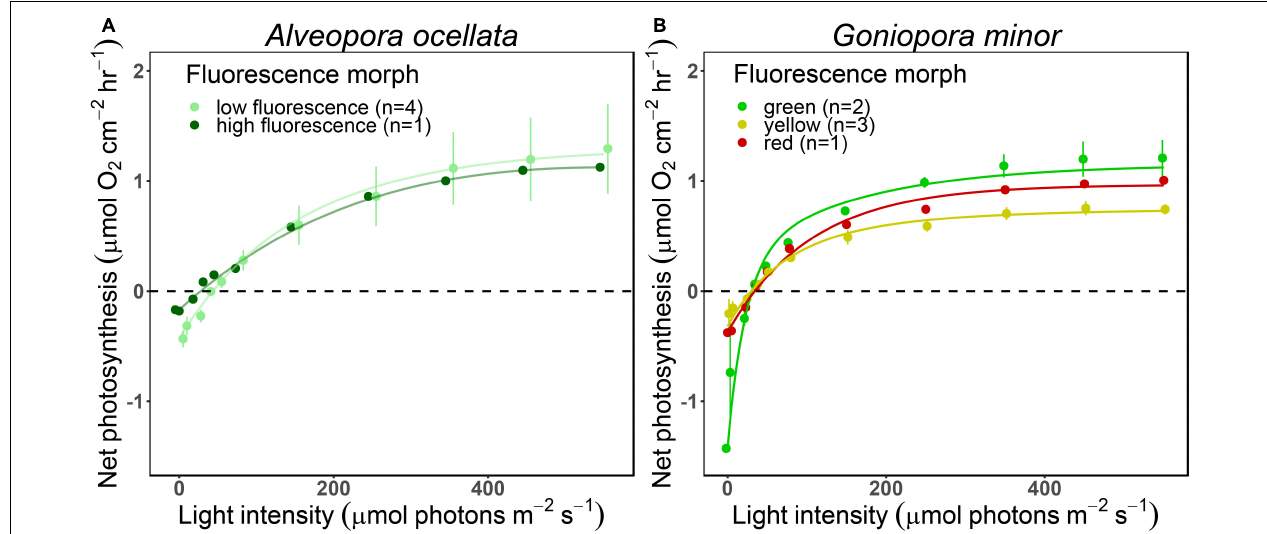
FIGURE 4 | Net photosynthesis of two mesophotic corals fluorescence morphs. Fitted (solid lines) and mean (circles) ± SE (error bars) values of O 2 evolution ( µ mol O 2 cm − 2 hr − 1 ) measured under blue light at increasing intensities (0, 5, 23, 36, 50, 78, 150, 250, 350, 450, and 550 µ mol photons m − 2 s − 1 ) of Alveopora ocellata [ (A) , n = 1 and 4 for high and low fluorescence morphs, respectively] and Goniopora minor [ (B), n = 2, 1, and 3 for green, red, and yellow morphs,